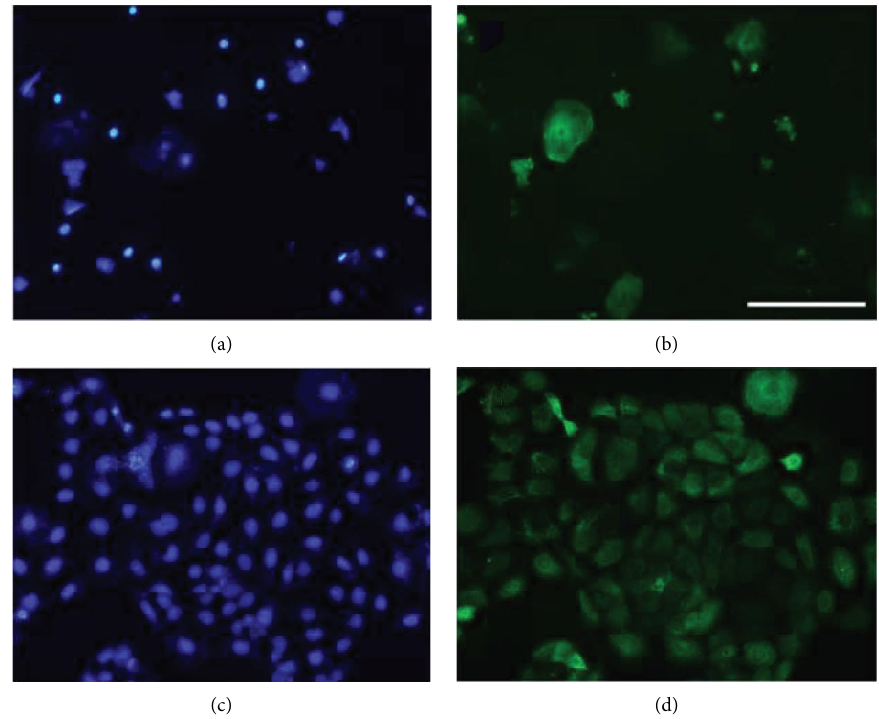
Figure 3: Both DOECs and HaCaT cells express immunoreactivity for the keratinocyte marker cytokeratin. (a–d) DOECs (a, b) were transferred to microscope slides by cytospin, and HaCaTcells (c, d) were cultured on coverslips. Cells were fxed and double stained for the nuclear marker DAPI (a, c) and for cytokeratin immunoreactivity (b, d). Te bar in panel (b) represents 150 μ m for all panels. Each sample was analyzed in